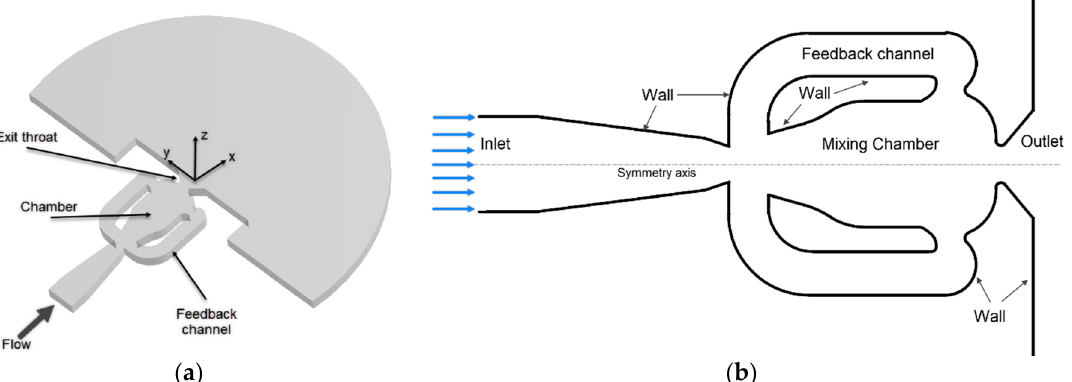
Figure 1. A schematic of the sweeping jet actuator, ( a ) computational domain, and ( b ) boundary conditions. Reproduced with permission from [9].